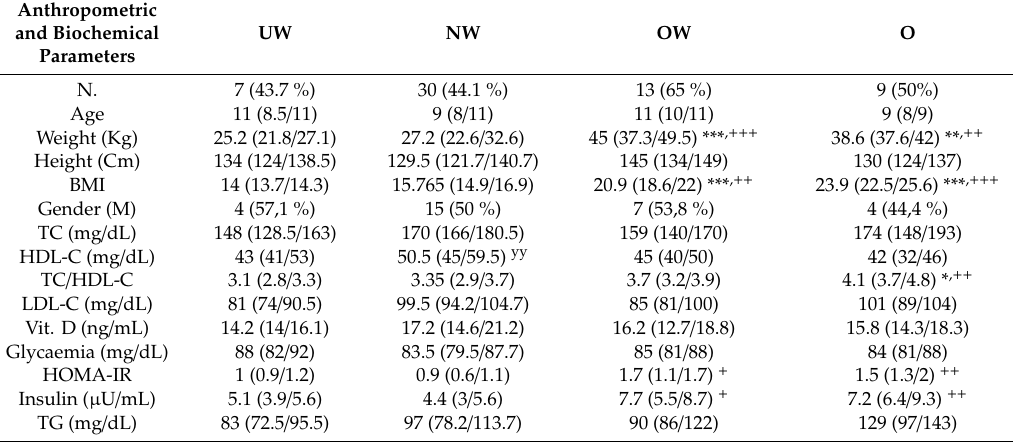
Table 1. Study participant’s anthropometry and biochemical assessment. Characteristics are described using median and interquartile range (if continuous) or counts and percentages (if categorical). One way ANOVA with Bonferroni’s correction was employed if data were normally distributed, otherwise Kruskal-Wallis’ with Dunn’s correction was adopted. (* represent p -value for UW, + represent p -value for NW, y represent p -value for O) * p -value < 0.05, ** p -value < 0.01, *** p -value < 0.001, + p -value < 0.05, ++ p -value < 0.01, +++ p -value < 0.001, yy p -value <